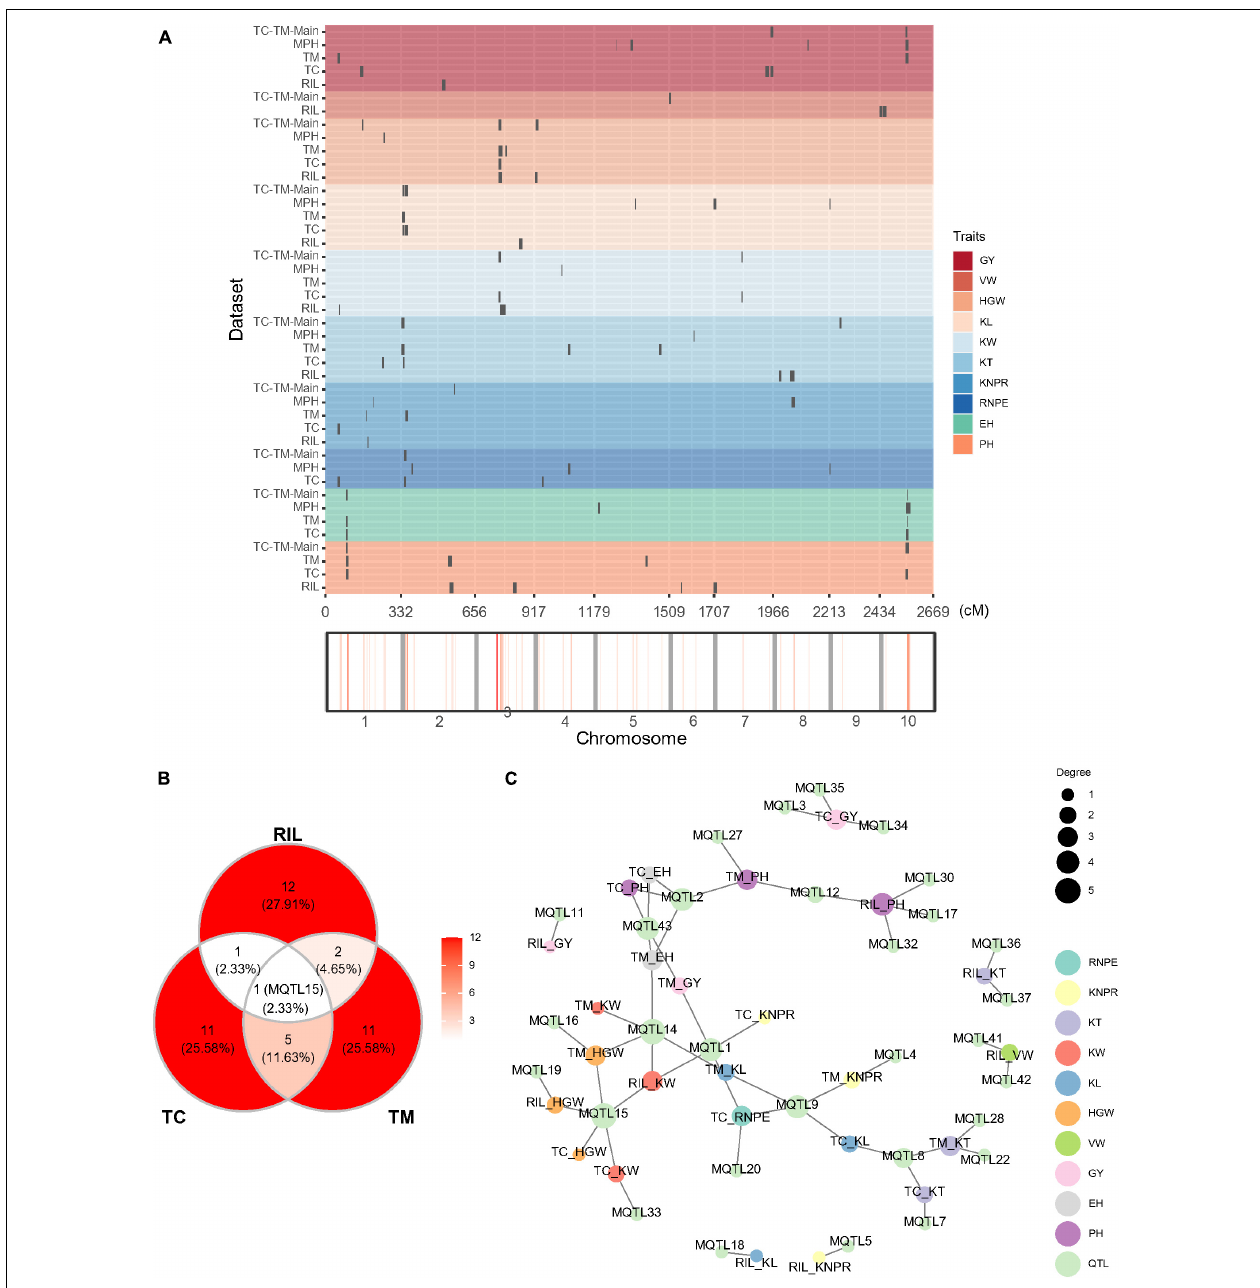
FIGURE 3 | Quantitative trait loci (QTL) distribution and pleiotropic QTL detected in the recombinant inbred line population developed by Ye478 × Qi319 (RIL), Chang7-2 × RIL (TC), and Mo17 × RIL (TM) populations. (A) QTL distribution and hotspots in the whole genome shown for RIL, TC, and TM populations. TC-TM-Main is the mapping results for the additive and dominance effects of QTL from the pooled population of TC and TM. MPH represents the result of dominance QTL mapping for MPH. (B) Venn diagram showing the numbers of overlapping QTL between the RIL, TC, and TM populations. (C) Trait-QTL network for the 10 traits and QTL identified in the RIL, TC, and TM populations. The connections between traits and QTL are linked if a QTL was identified for the respective trait. PH, plant height; EH, ear height; RNPE, row number per ear; KNPR, kernel number per row; KT, kernel thickness; KW, kernel width; KL, kernel length; VW, volume weight; HGW, hundred grain weight; GY, grain yield per